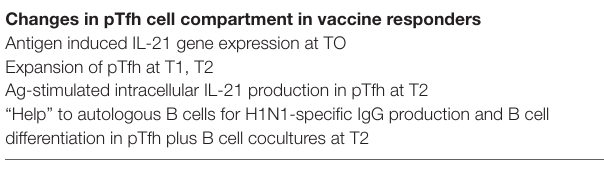
TABLe 1 | Signature immunological changes in pTfh and B cells in vaccine responders (VRs) following influenza vaccine at TO (baseline), T1 (7 days), and T2 (4